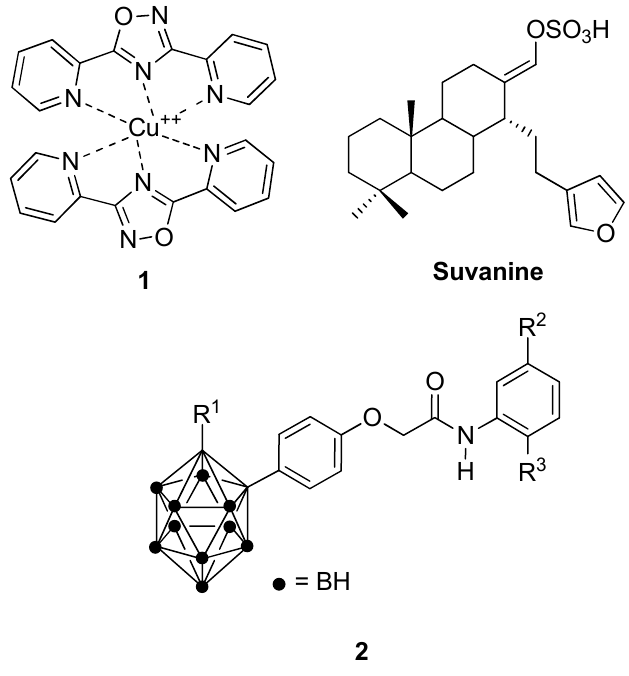
Figure 4. Chemical structures of Hsp60 modulators.